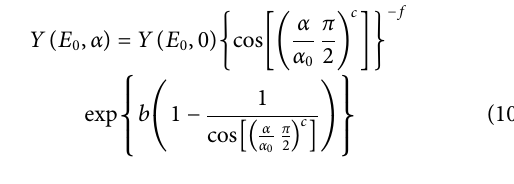
Frontiers in Physics |